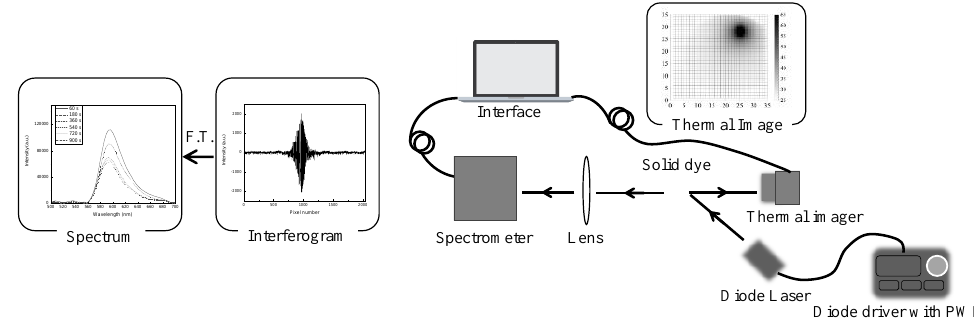
Figure 3. The experimental setup used to investigate the spectral and thermal properties.